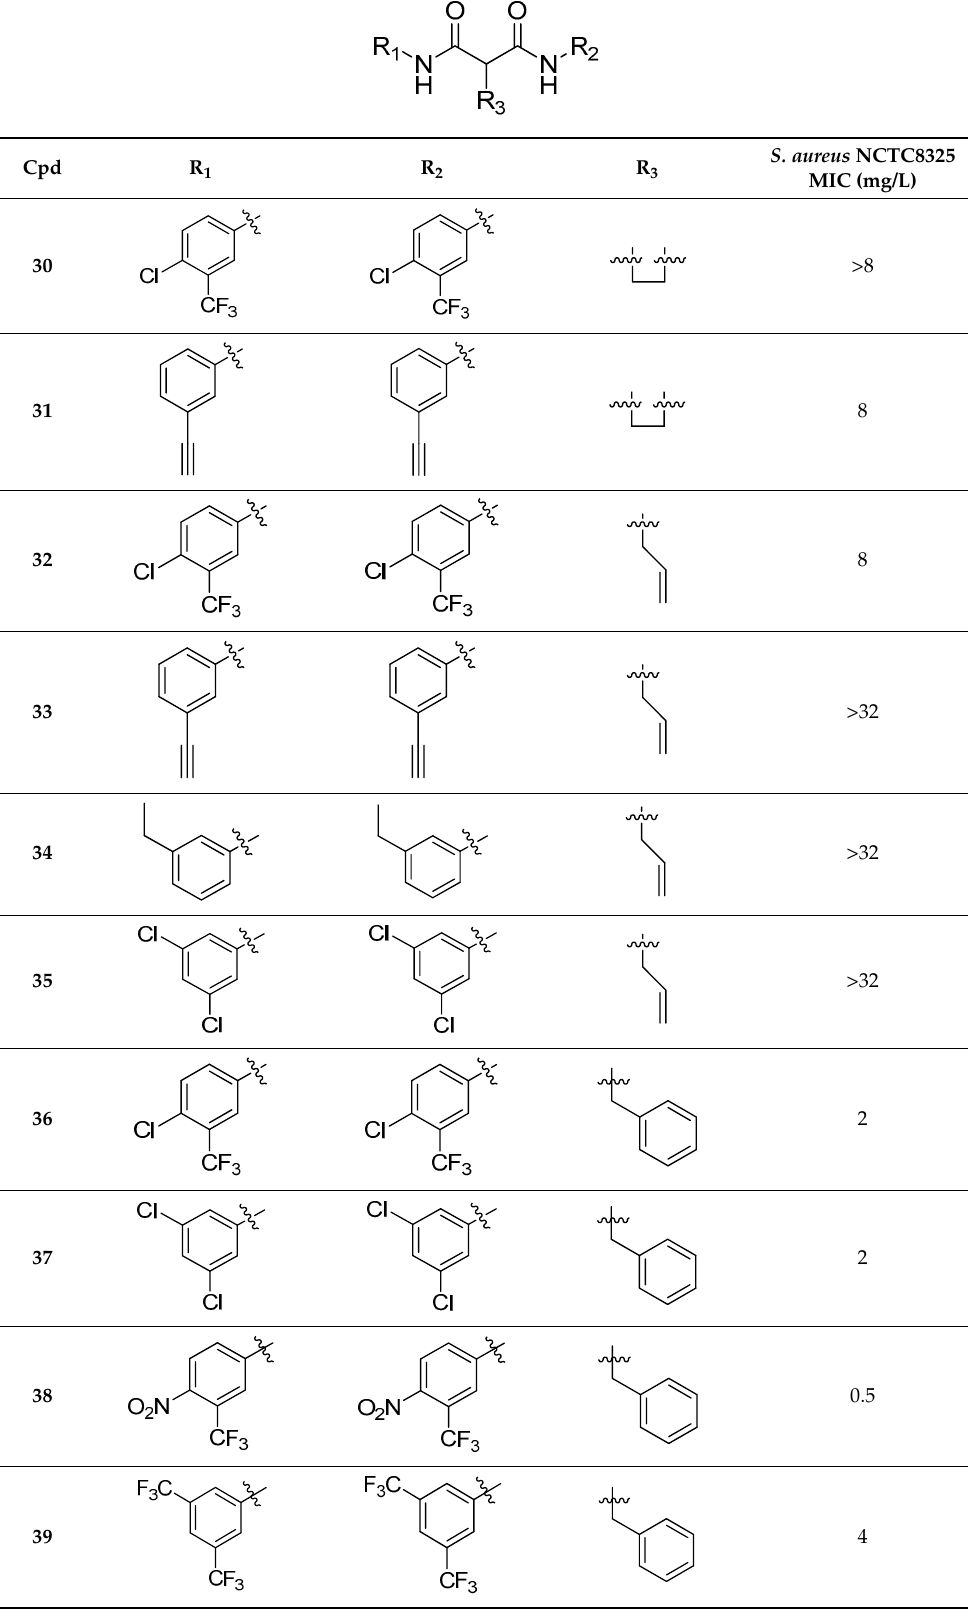
Table 3. Antibacterial activity of cyclopropanyl-, allyl- and benzyl-substituted malonate derivatives against S. aureus NCTC8325.